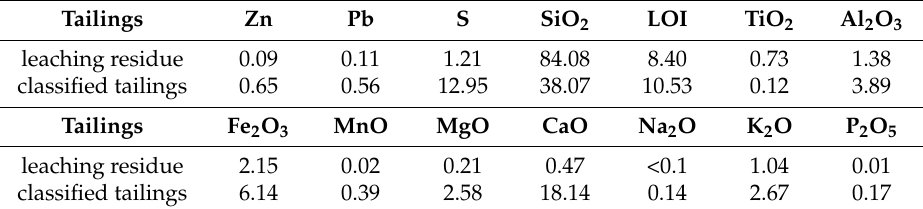
Table 2. Chemical composition of leaching residue size and classified tailings (unit in wt %).